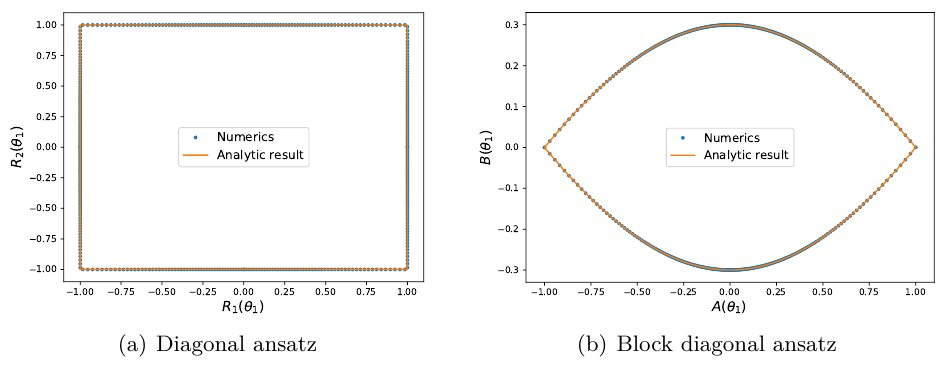
Figure 12 . Allowed regions for a free bulk at θ 1 = 0 . 9879 i in agreement with analytic